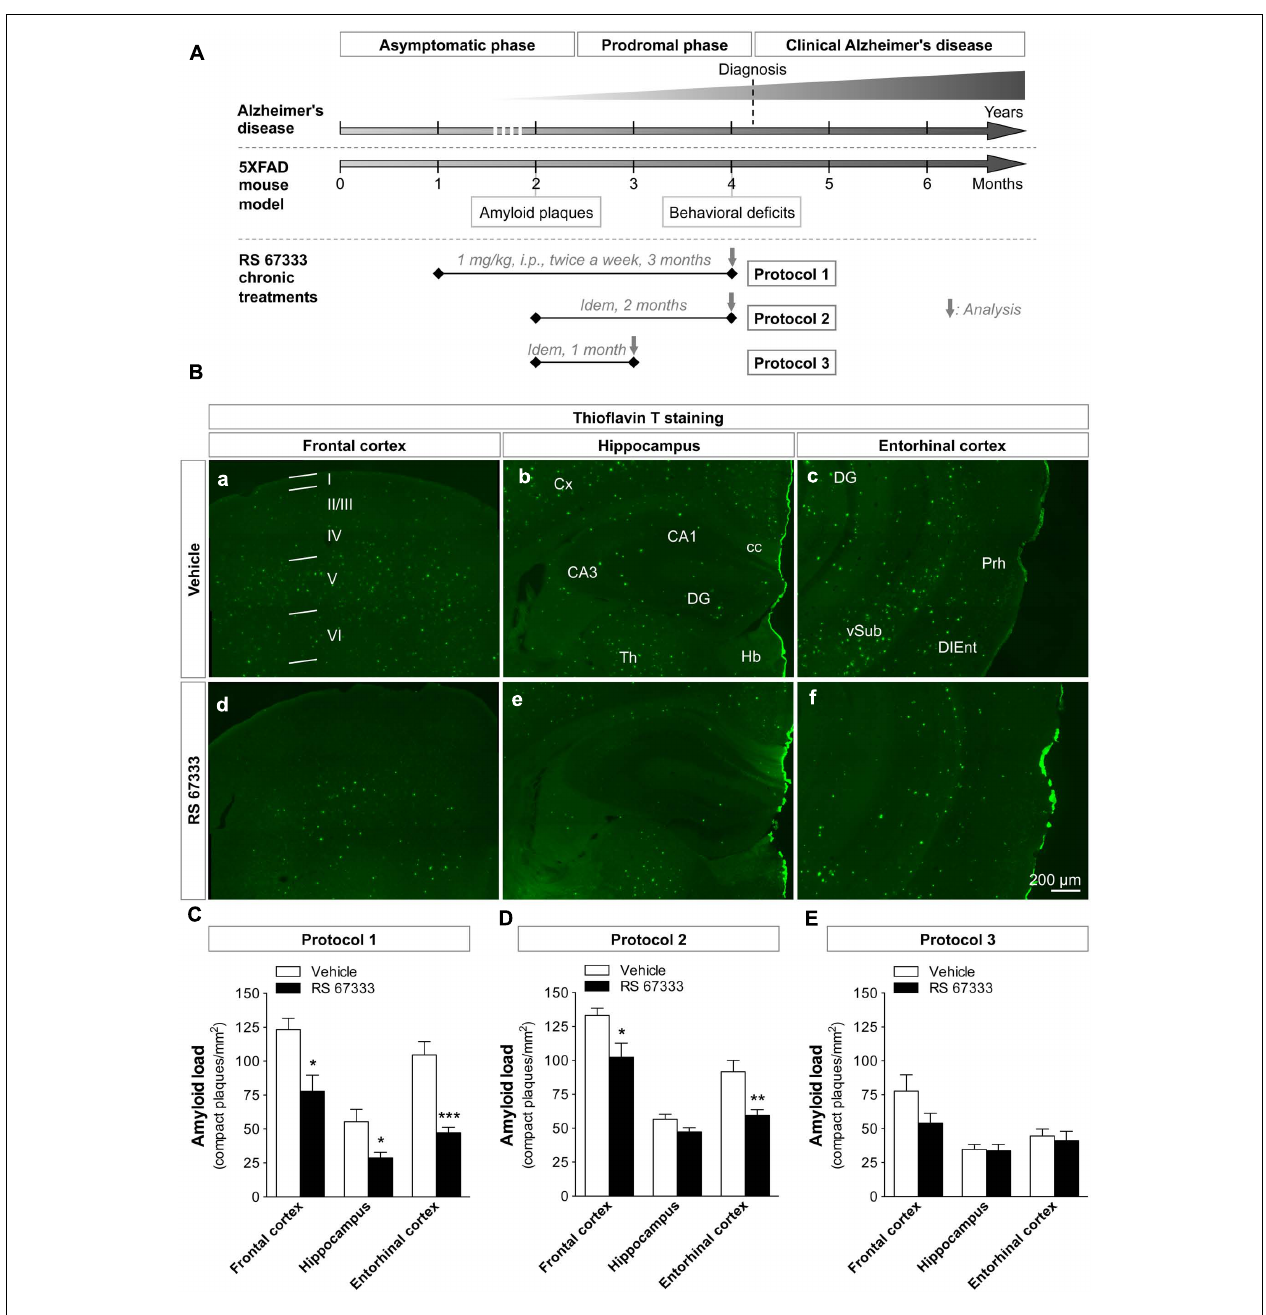
FIGURE 2 | Early, chronic administration of RS 67333 reduces the amyloid plaque load in 5XFAD mice. (A) Schematic model comparing the progression of AD in humans and of the AD-like pathology in 5XFAD mice. A β accumulation in 5XFAD mice starts at 2 months of age, which corresponds to AD asymptomatic phase in humans.The first memory and behavioral deficits in 5XFAD mice appear at about 4 months of age, which corresponds to the prodromal phase preceding the time of diagnosis in humans (clinical AD), prior to progressive accumulation of neuropathological alterations and memory deficits in 5XFAD mice.The time-course of the three different treatment protocols (protocols 1–3) with the 5-HT 4 receptor agonist RS 67333 (1 mg/kg, i.p., twice a week) is shown below the schematic of disease progression. At the end of the treatment, the behavioral NOR test (only for mice treated according to protocol 2), A β 40 and A β 42 measurements in brain